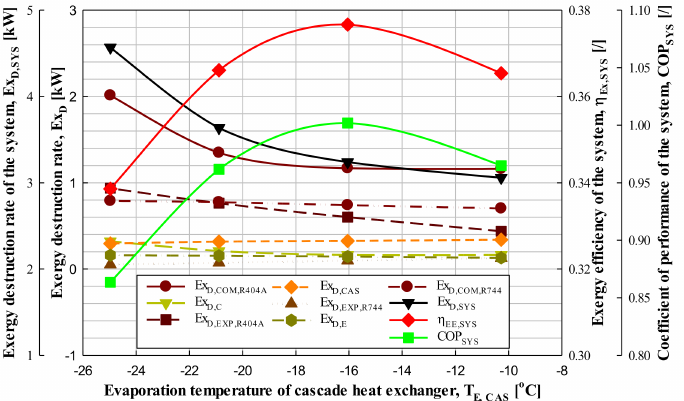
Figure 9. Exergy destruction rate, exergy efficiency and COP of the CRS with respect to the evapora- tion temperature of the cascade heat